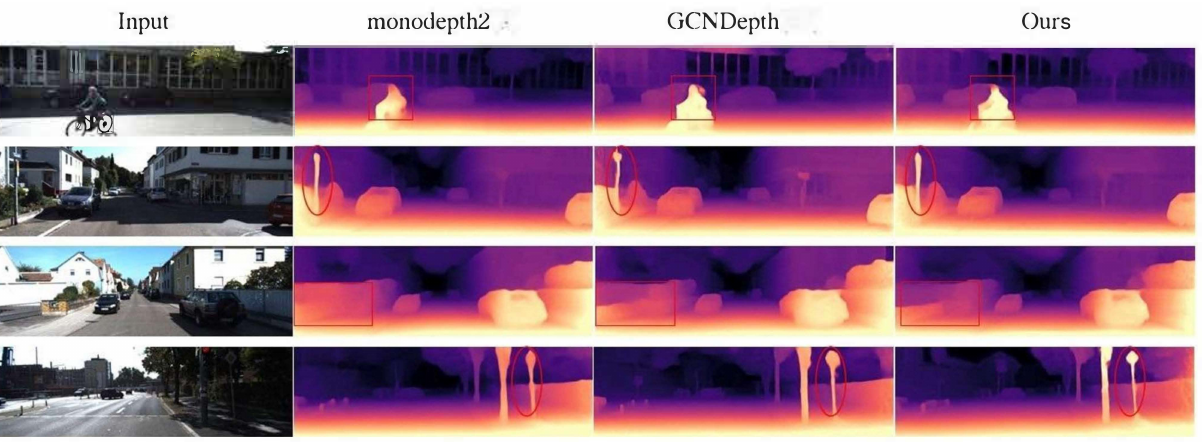
Figure 4. We train our model on the KITTI dataset and compare it with the experimental results of monodepth2 [9] and GCNDepth [58]. The main differences in the experiment are marked with red boxes, and our model achieves better results.